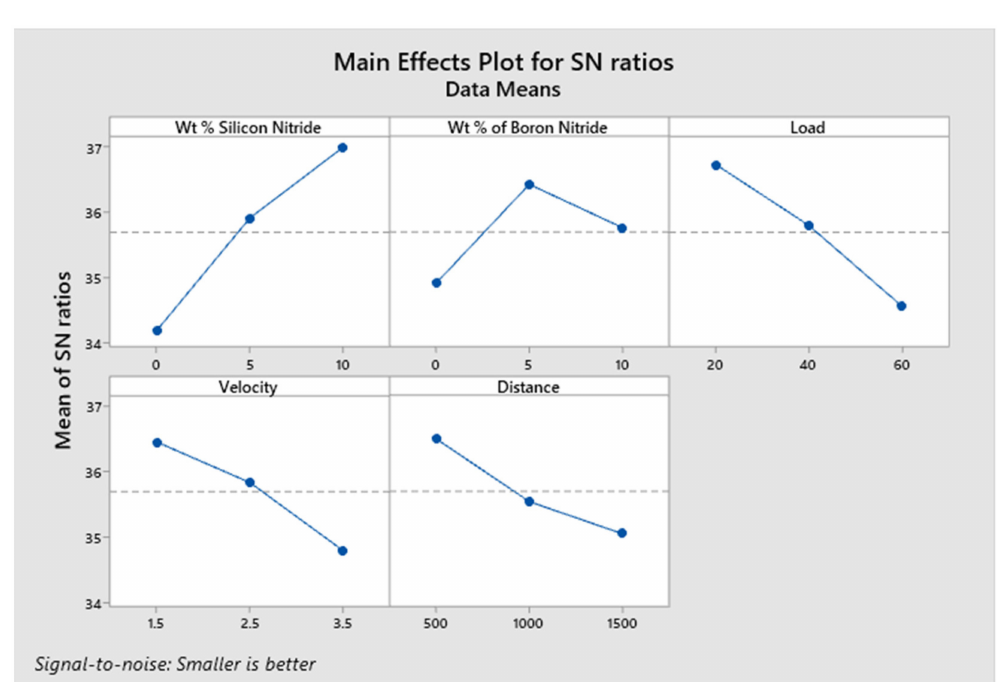
Figure 4. Effect of independent process parameters on the wear